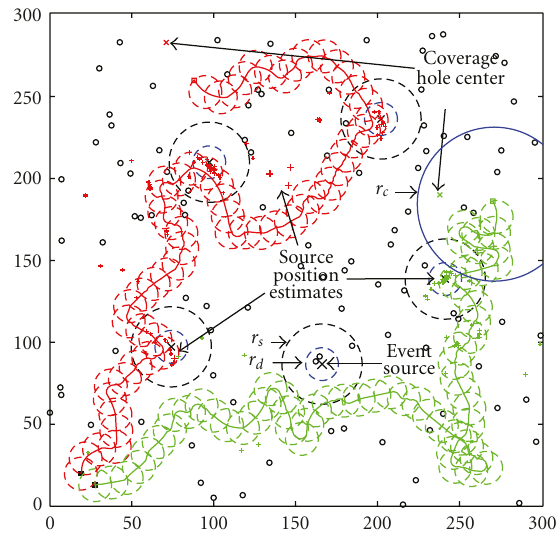
Figure 6: Dynamic distributed path planning using a team of two mobile nodes in the presence of event sources.